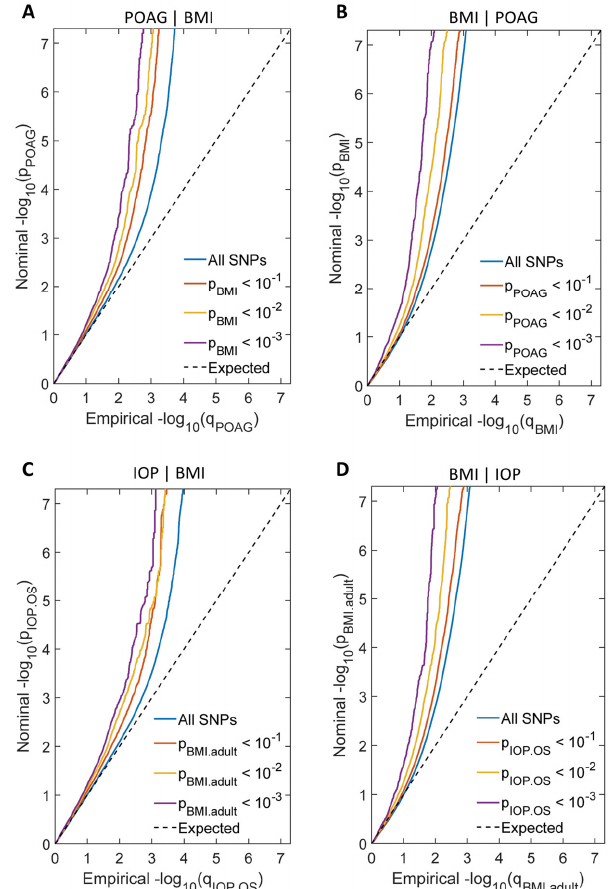
Figure 3. Conditional Q-Q plots showed cross-trait enrichment between POAG/IOP and BMI. ( A ) Conditional Q-Q plot of nominal—log10(p) for SNPs association with POAG as a function of statistical significance for SNPs association with BMI at the predefined stratum of p values. The lines with sharp leftward deviated tails showed the true associations between POAG and BMI. ( B ) Conditional Q-Q plot of nominal—log10(p) for SNPs association with BMI as a function of statistical significance for SNPs association with POAG at the predefined stratum of p values. The lines with sharp leftward deviated tails showed the true associations between BMI and POAG. ( C ) Conditional Q-Q plot of nominal—log10(p) for SNPs association with IOP as a function of statistical significance for SNPs association with BMI at the predefined stratum of p values. The lines with sharp leftward deviated tails showed the true associations between IOP and BMI. ( D ) Conditional Q-Q plot of nominal—log10(p) for SNPs association with BMI as a function of statistical significance for SNPs association with IOP at the predefined stratum of p values. The lines with sharp leftward deviated tails showed the true associations between BMI and